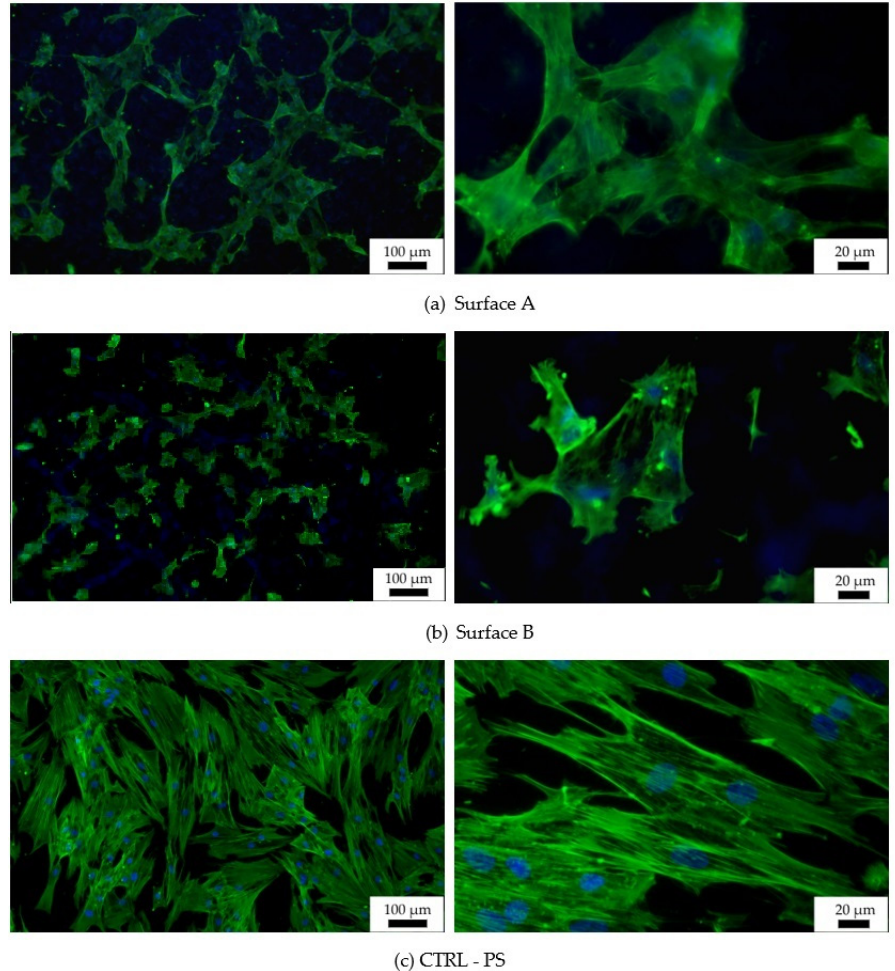
Figure 9. Fluorescent images of hMSCs cultivated for 72 h on graphite-Ti samples. Staining of actin by PhalloidinAlexaFluor 488 (green) and of the nucleus by DAPI (blue); ( a ) Surface A, ( b ) Surface B, ( c ) surface of the control tissue-culture treated PS sample (CTRL—PS).